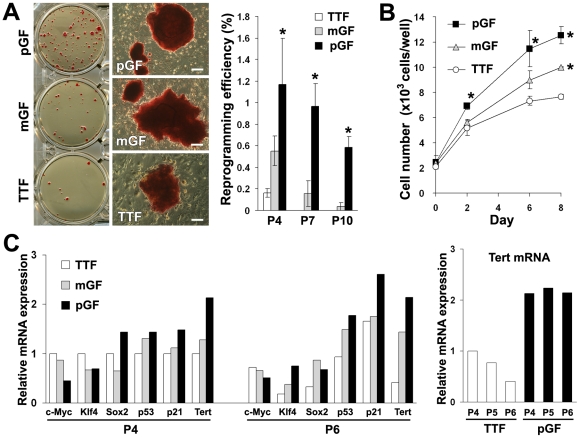
Reprogramming efficiency of mouse GF- and TTF-derived iPS cells.(A) Fibroblasts established from palatal (pGFs) and mandibular (mGFs) gingival tissues as well as tail-tips (TTFs) of the same mouse were simultaneously induced into iPS cells by four-factor transduction. Left panels: ES cell-like colony formation from each cell type at passage 4 was determined by ALP staining (Scale bars; 200 µm). Right panel: The reprogramming efficiency at passages 4, 7 and 10 was calculated as the number of ALP-stained iPS colonies formed per number of infected cells seeded. The data represent the mean values ± s.d. (n = 4). Significant differences (*P<0.01: ANOVA with Dunnett's correction for multiple comparisons) were evaluated with respect to the values for TTF at each passage number of cultures. (B) A cell proliferation assay was performed on the pGF, mGF and TTF cultures at passage 5. The data represent the mean values ± s.d. (n = 3). Significant differences (*P<0.01: ANOVA with Dunnett's correction for multiple comparisons) were evaluated with respect to the values for TTF at each time point. (C) Real-time RT-PCR analysis for endogenous expression of c-Myc, Klf4, Sox2, p53, p21 and Tert genes in pGFs, mGFs and TTFs at passages 4 and 6 (left panel). The expression level of Tert mRNA in pGFs was maintained for 6 passages, while that in TTFs decreased as the passage number increased (right panel). Expression of GAPDH was used as an internal control. The data represent the relative mRNA expression levels with respect to the expression levels of each gene in TTFs at passage 4.